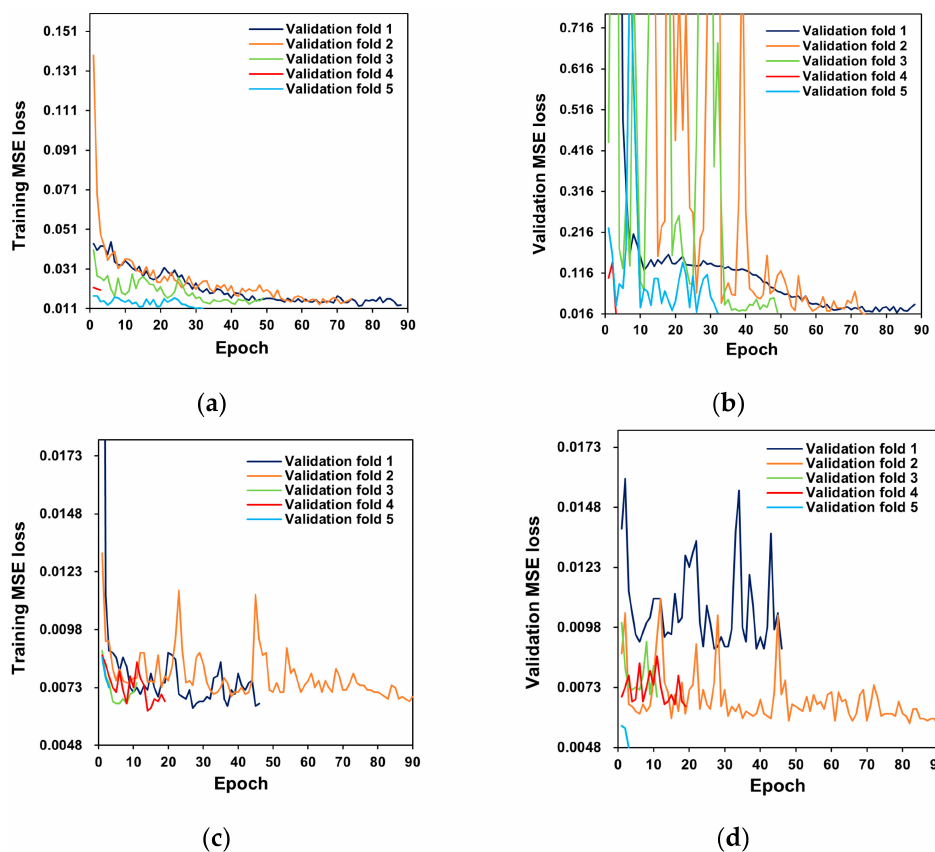
Figure 6. Change in training loss and validation loss during training of the developed model: ( a ) training loss in the first stage, ( b ) validation loss in the first stage, ( c ) training loss in the second stage, and ( d ) validation loss in the second stage. Repetition of loss reduction depicts five-fold cross-validation. The model weight was not kept when the validation loss did not converge in every fold to avoid